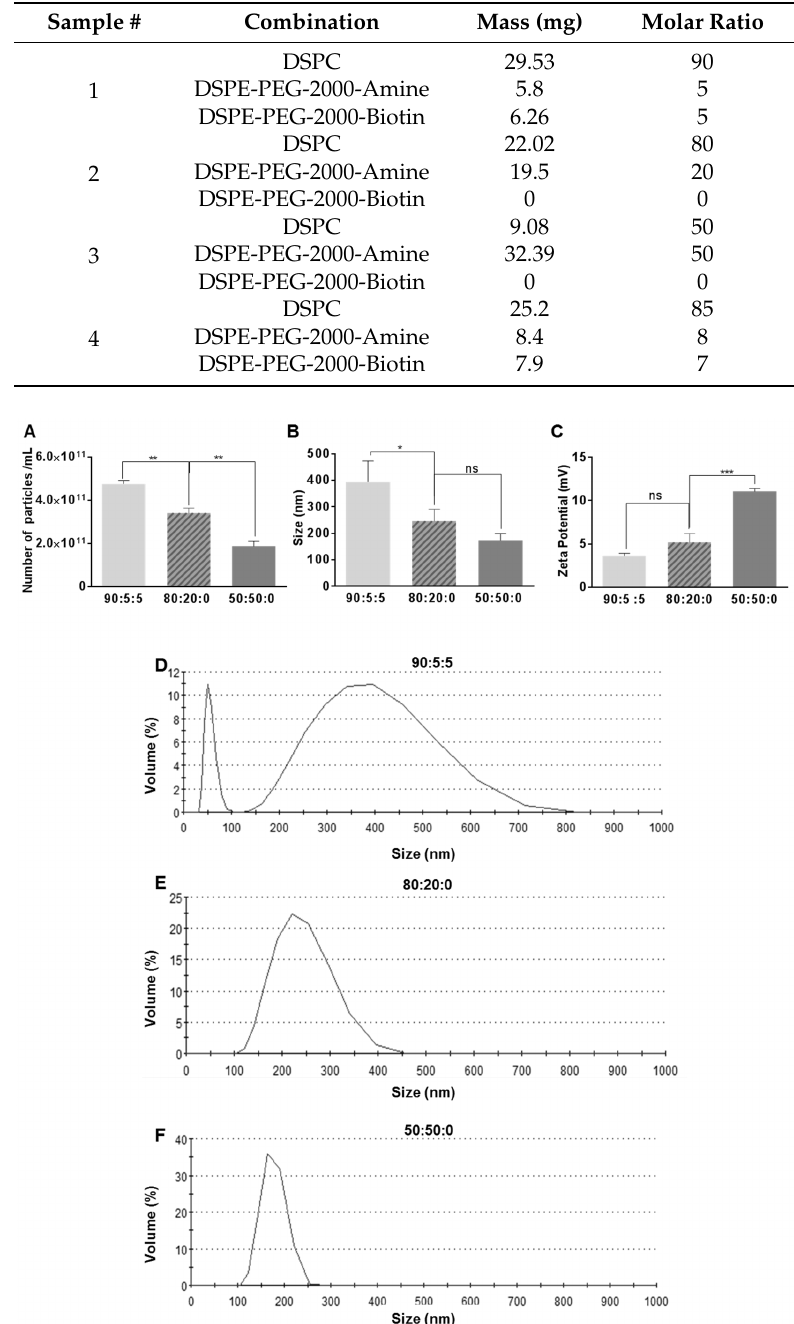
Figure 1. Impact of various compositions on the number ( A ), the size ( B ) and the zeta potential ( C ) of nanobubbles. Dynamic light scattering (DLS) data on the size distribution for 90:5:5 ( D ), for 80:20:0 ( E ), and for 50:50:0 (F ). Here, *, **, ***, andindicate p-values of less than 0.05, 0.01, 0.001, and 0.0001, respectively.